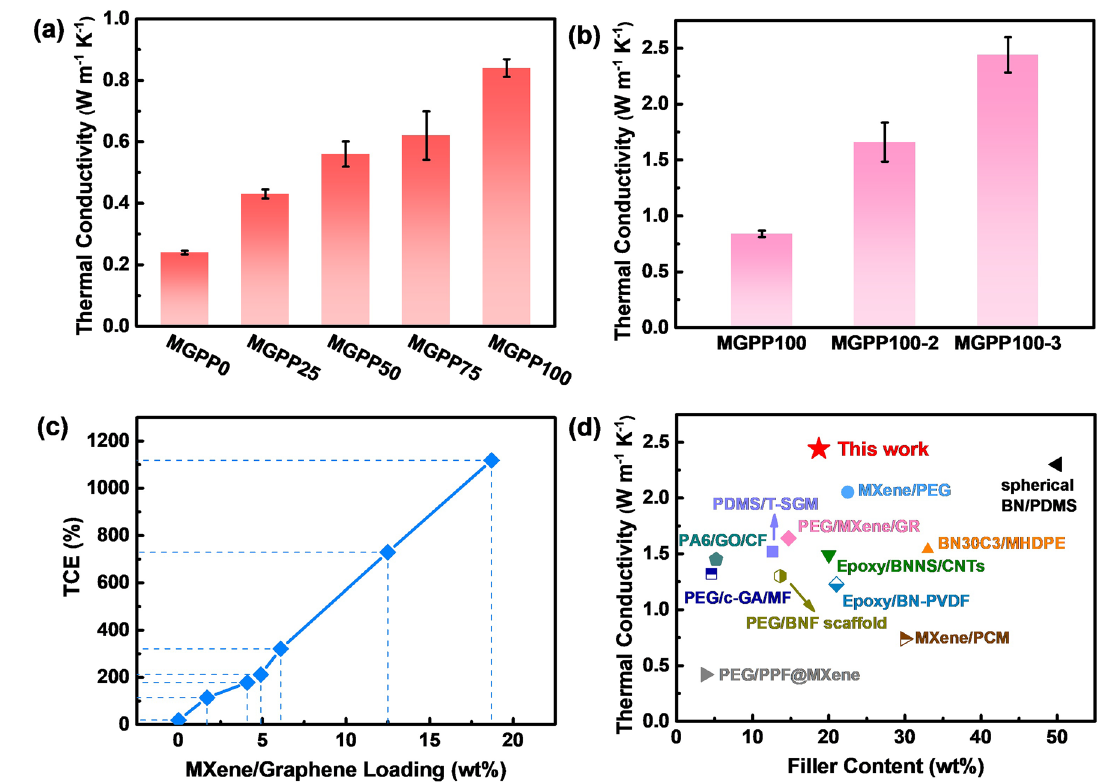
Fig. 3 Through-plane thermal conductivity of MGPP composites with different a concentration and b number of cycles. c TCE with MXene/ graphene loading. d Comparison of thermal conductivity of different 3D network filled composites: spherical BN/PDMS [54],